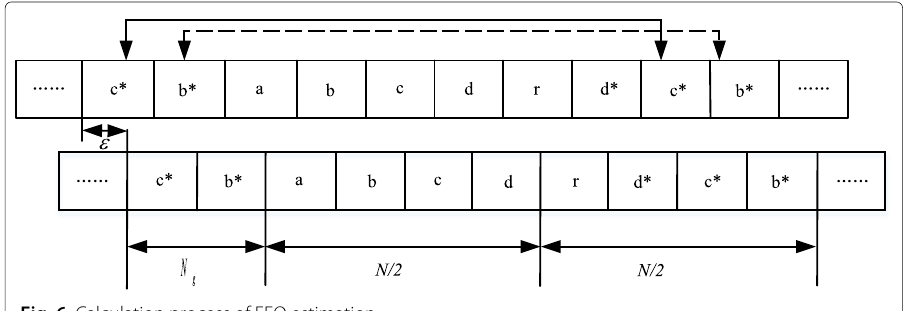
Fig. 6 Calculation process of FFO